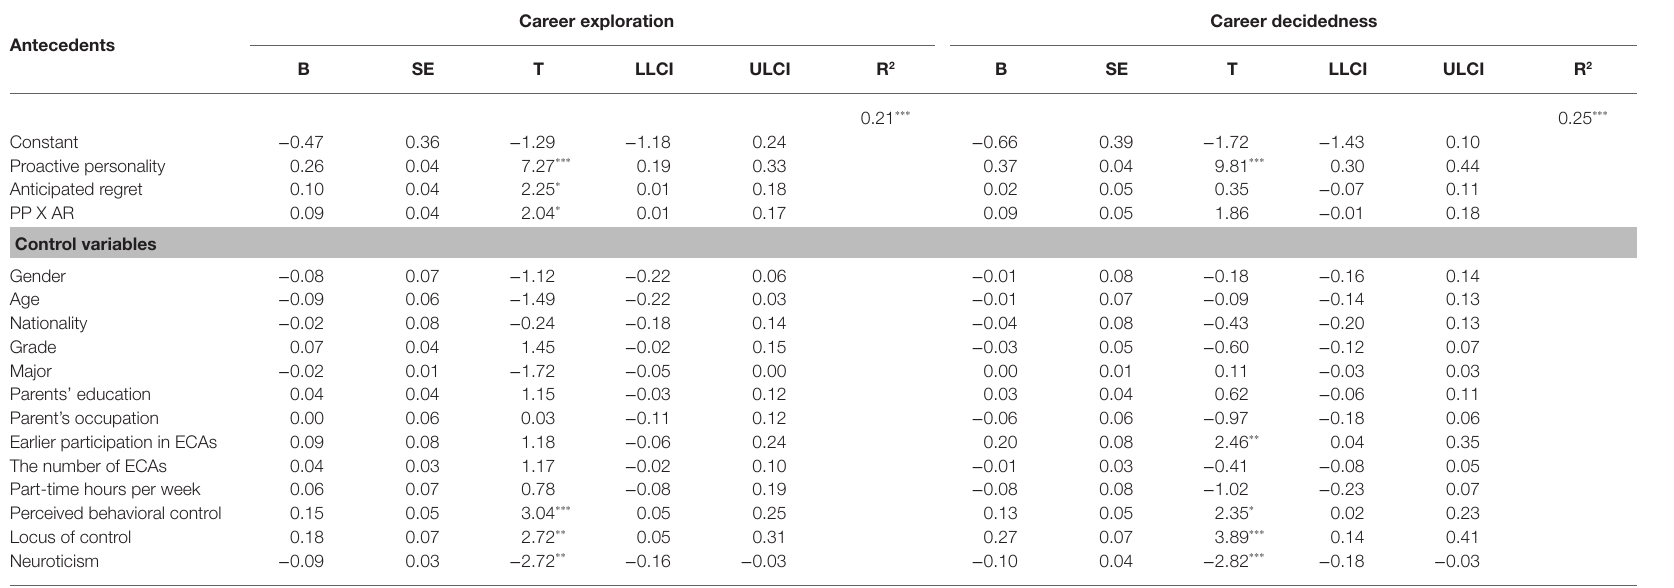
TABLE 5 | Results of moderation